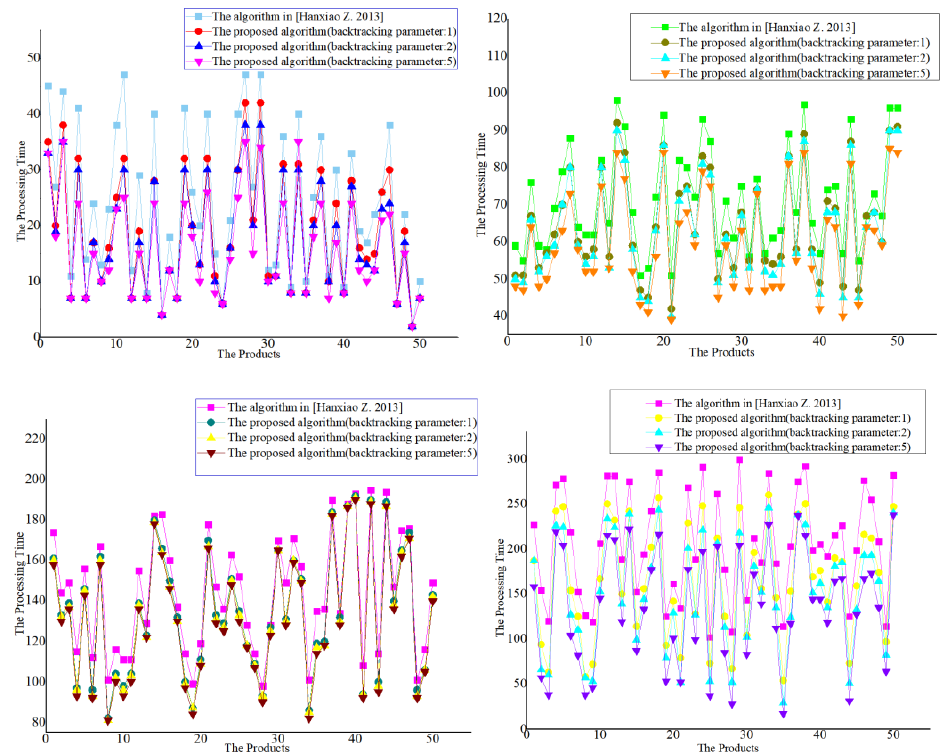
Figure 11. Comparison between the proposed algorithm and Ref. [15].